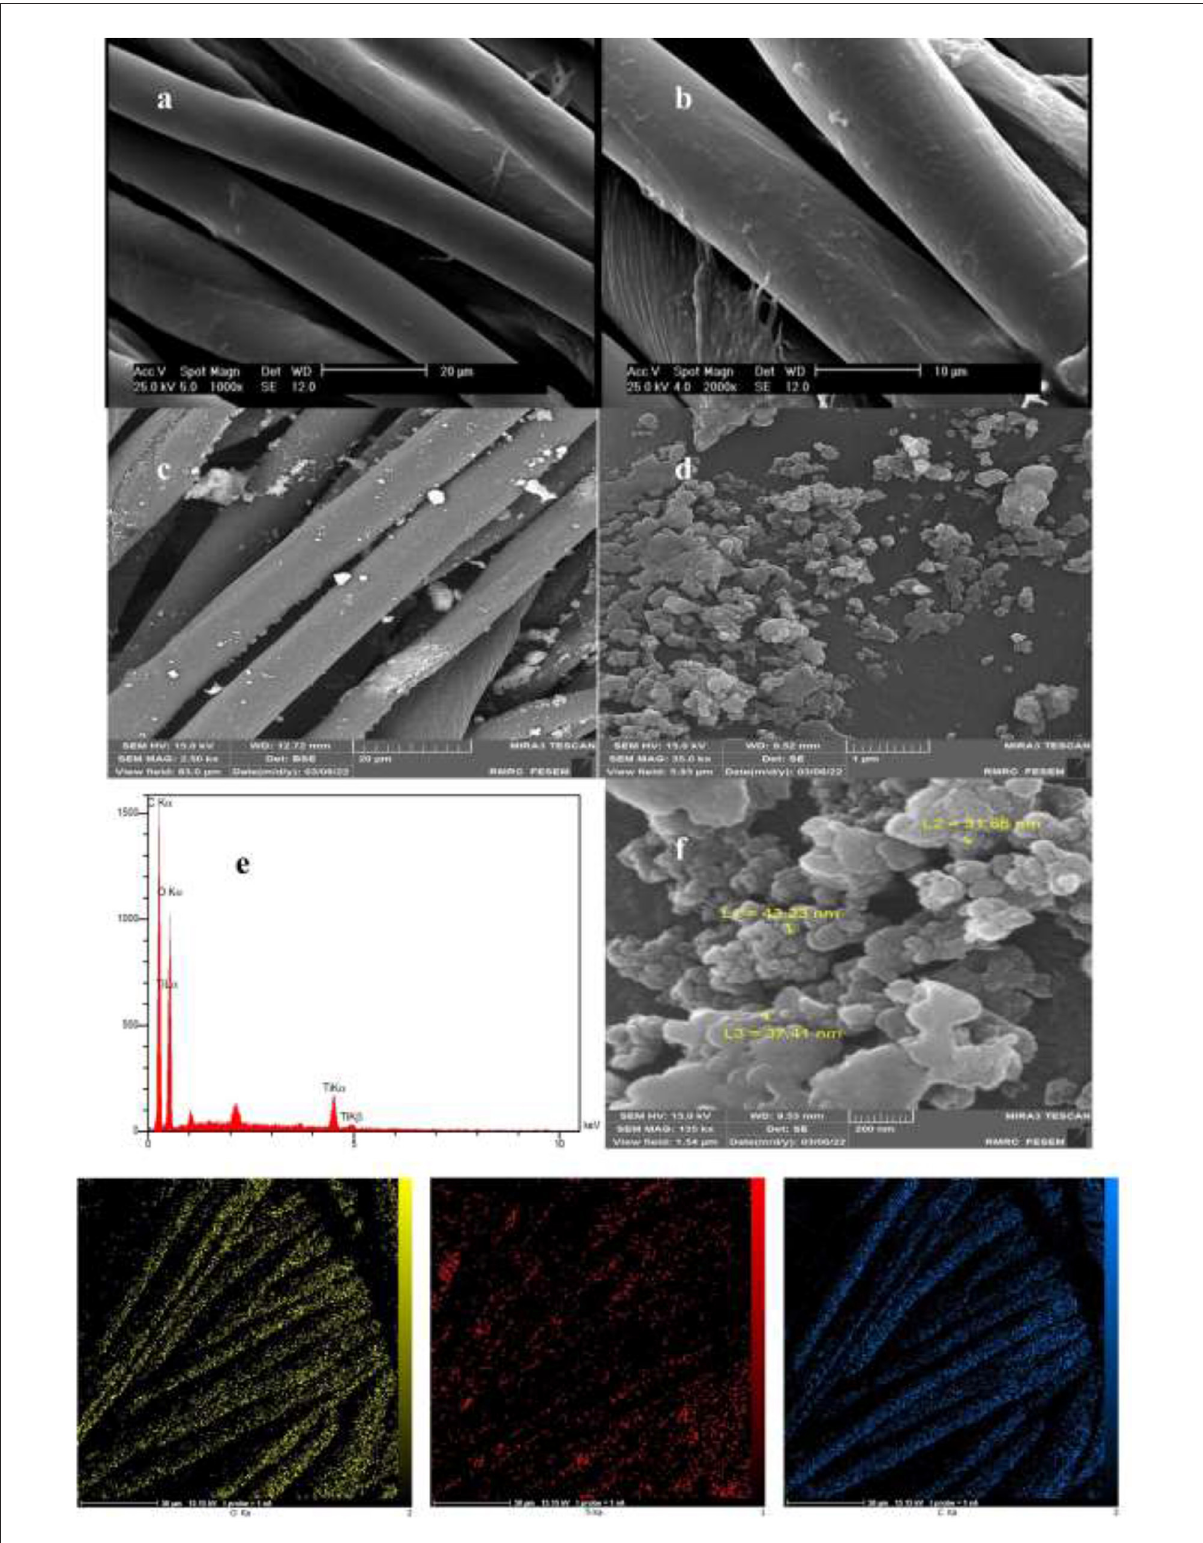
FIGURE1 EDX and SEM analysis of TiO 2 nanoparticles coating: (a,b) Imaging of the uncoated fabric with image sizes of 20 and 10 µ m. (c,d,f) Imaging of TiO 2 -coated fabric with image sizes of 20, 1 µ m, and 500nm. (e) EDX spectra of the agents coated onto the fabric